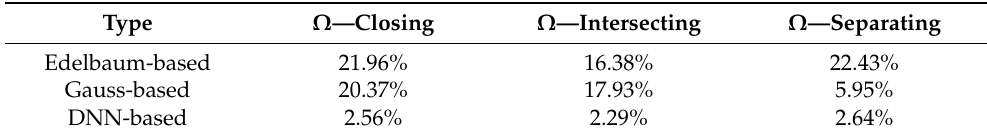
Table 5. MREs of the estimation for the two analytical methods and DNN-based method.